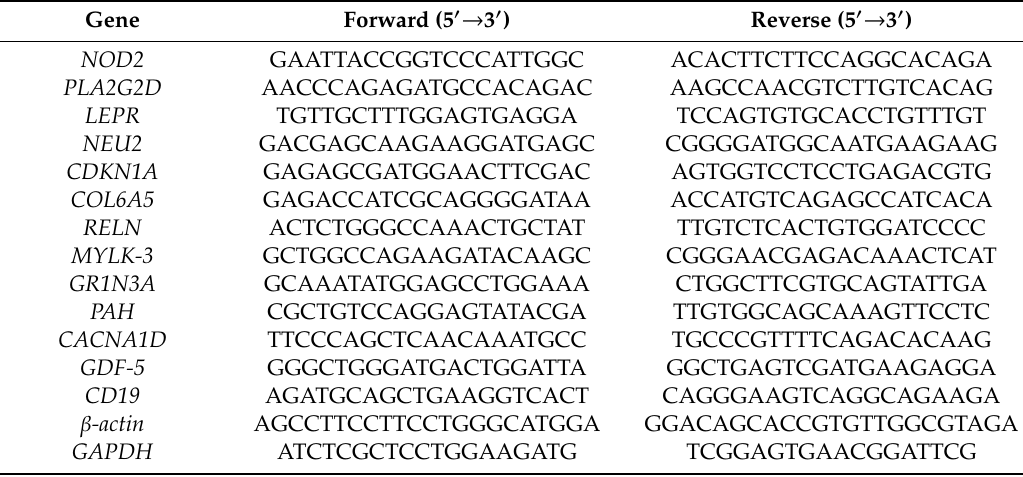
Table 1. Primers used for the RT-qPCR analyses.